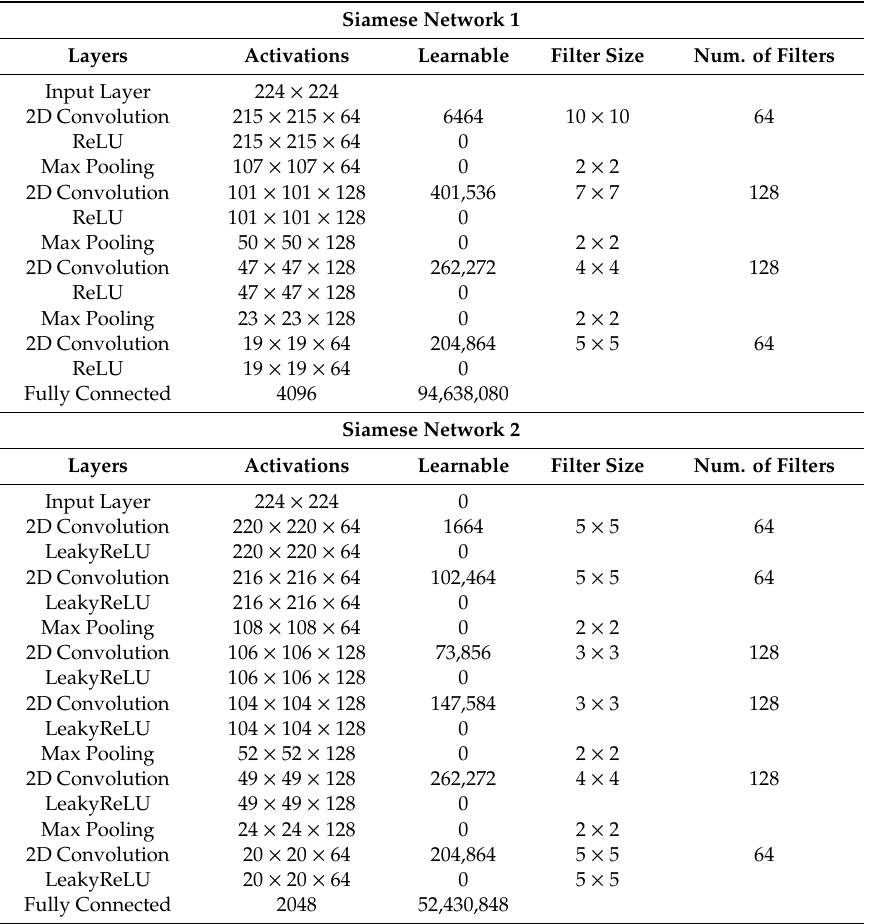
Table 1. Convolutional neural network (CNN) Siamese networks (1–4)